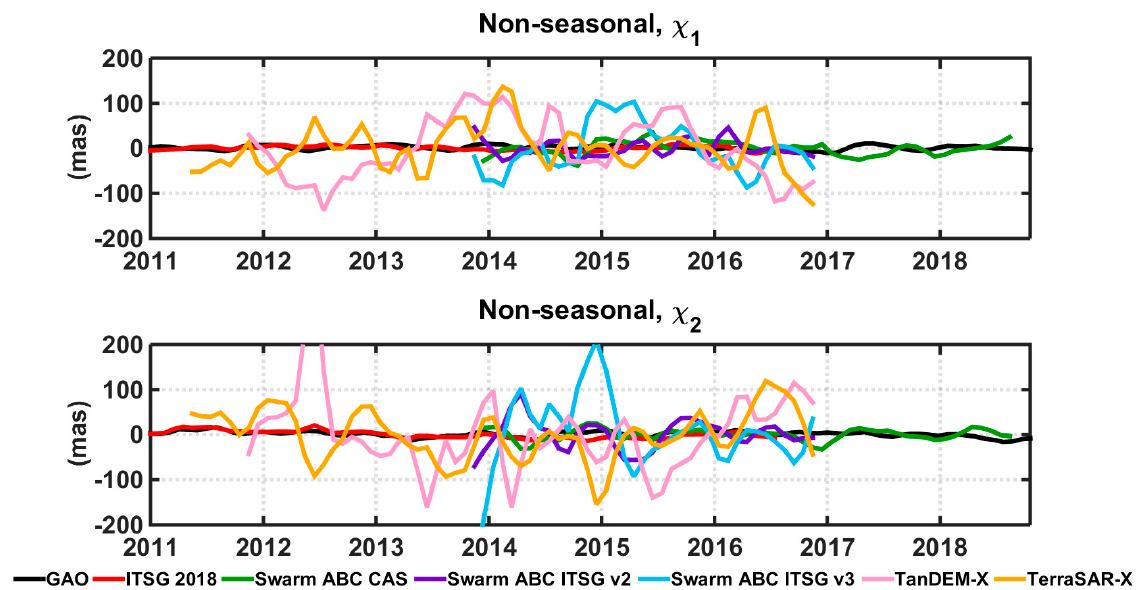
Figure 5. The χ 1 and χ 2 non-seasonal components of GAO and HAM obtained from: (1) ITSG 2018 GRACE solution (ll-SST), and (2) solutions based on kinematic orbits of Swarm ABC, TanDEM-X, and TerraSAR-X satellites (hl-SST).